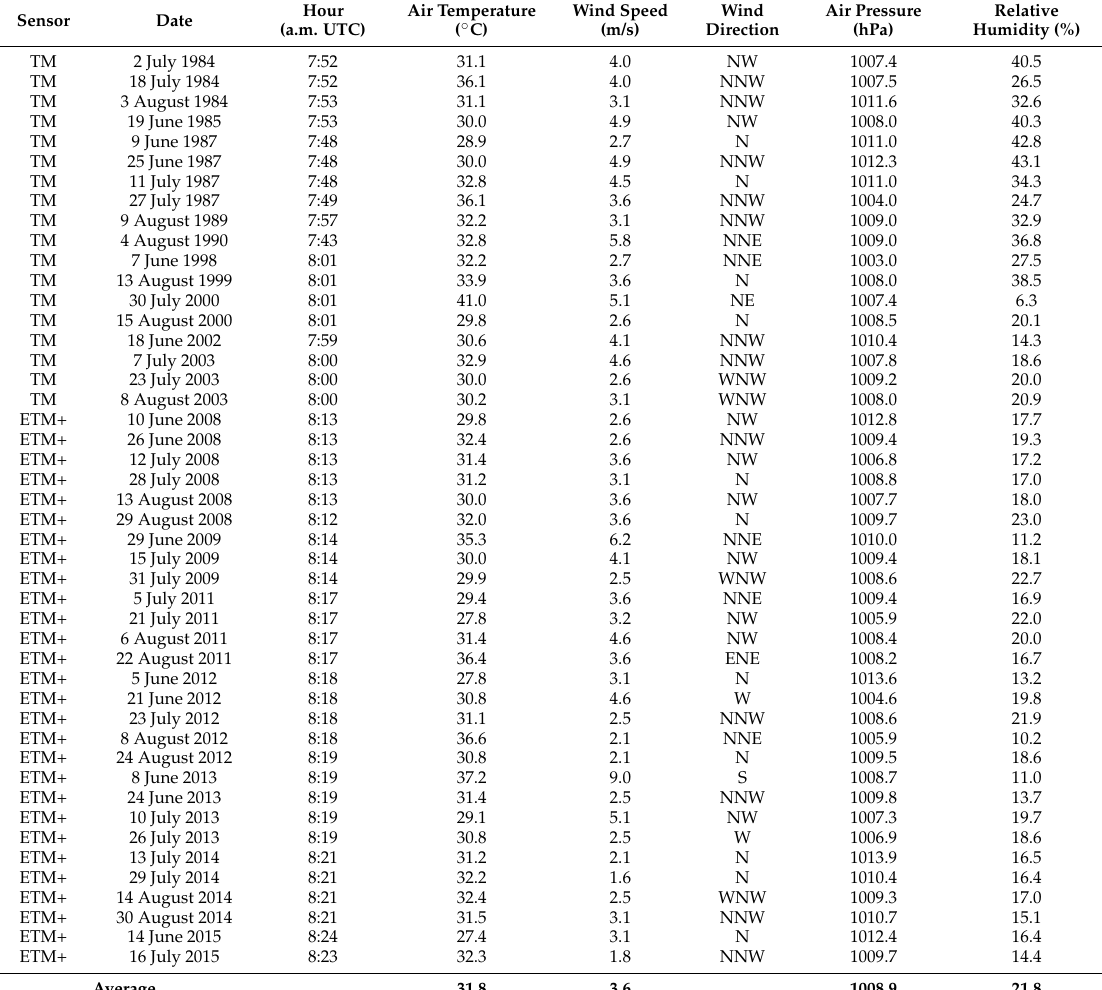
Table 2. The characteristics of the utilized Landsat images and their almost concurrent (8:00 a.m. UTC) meteorological